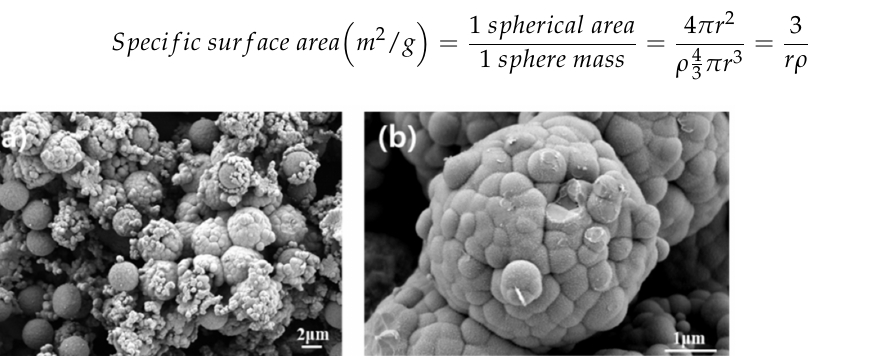
Figure 9. SEM image of polymer beads coated with metal: ( a ) image taken at 8.0 K magnification and ( b ) image taken at 40.0 K